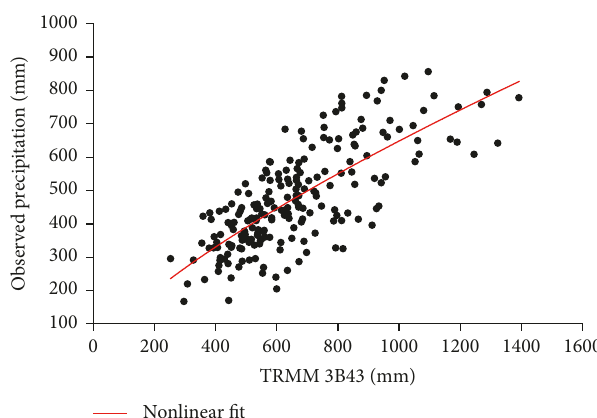
Figure 2: A comparison of annual TRMM 3B43 precipitation and observed precipitation during